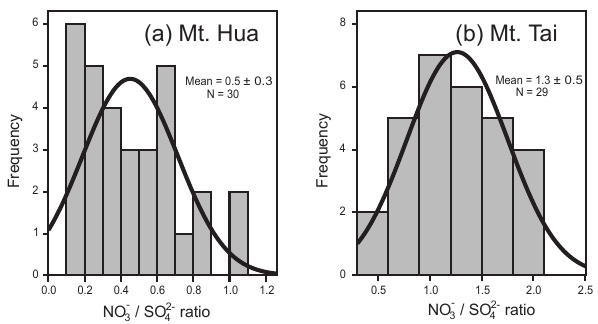
Fig. 6. Frequency of PM 10 samples containing nitrate with a con-